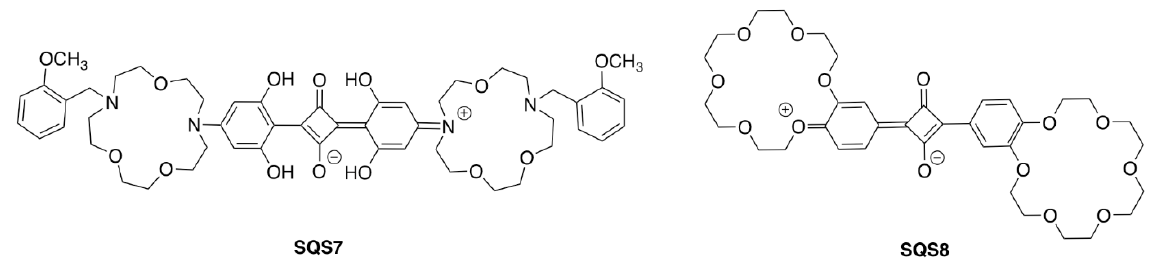
Figure 2. Structures of symmetric lariat diaza-crown ether-containing SQS7 [62] and benzo-18-crown-6-containing SQS8 [63].